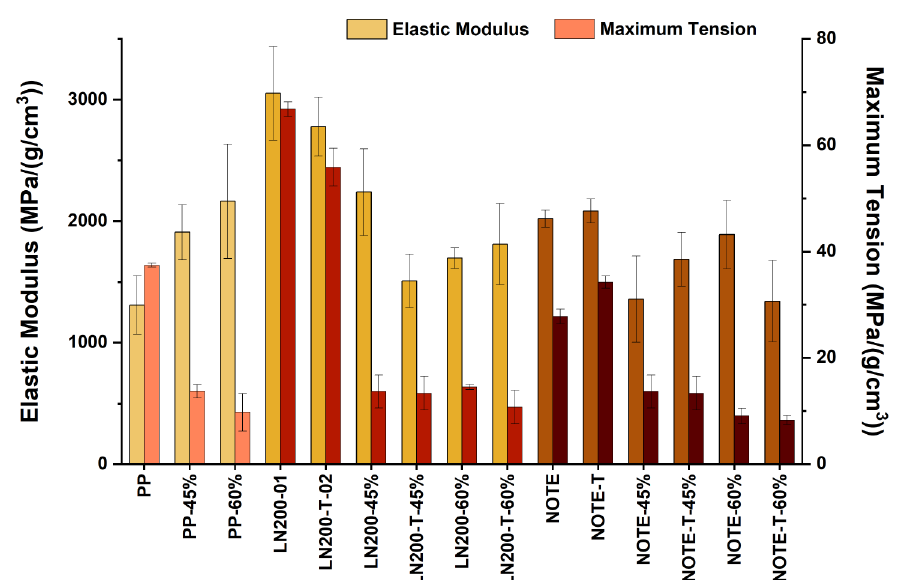
Figure 7: Tensile specific